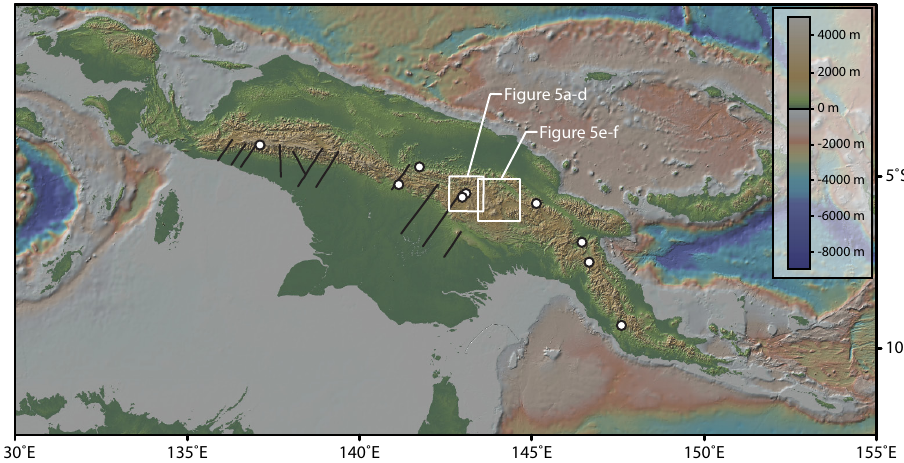
Fig. 3. A topographic and bathymetric map of New Guinea and the Arafura Sea using the Global Multi-Resolution Topography (GMRT) data set (Ryan et al., 2009) shows that there are no pronounced NNE striking lineaments. The location of New Guinea’s copper and gold deposits (white circles) and the NNE-trending lineaments (thin black lines) that were proposed by Hill (1991) and Kendrick et al. (1995) are also